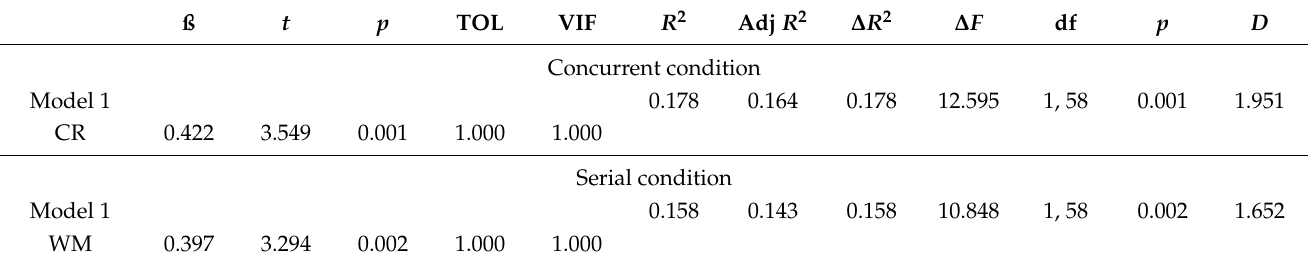
Table 6. Results of the stepwise regression analyses for noncanonical sentences.